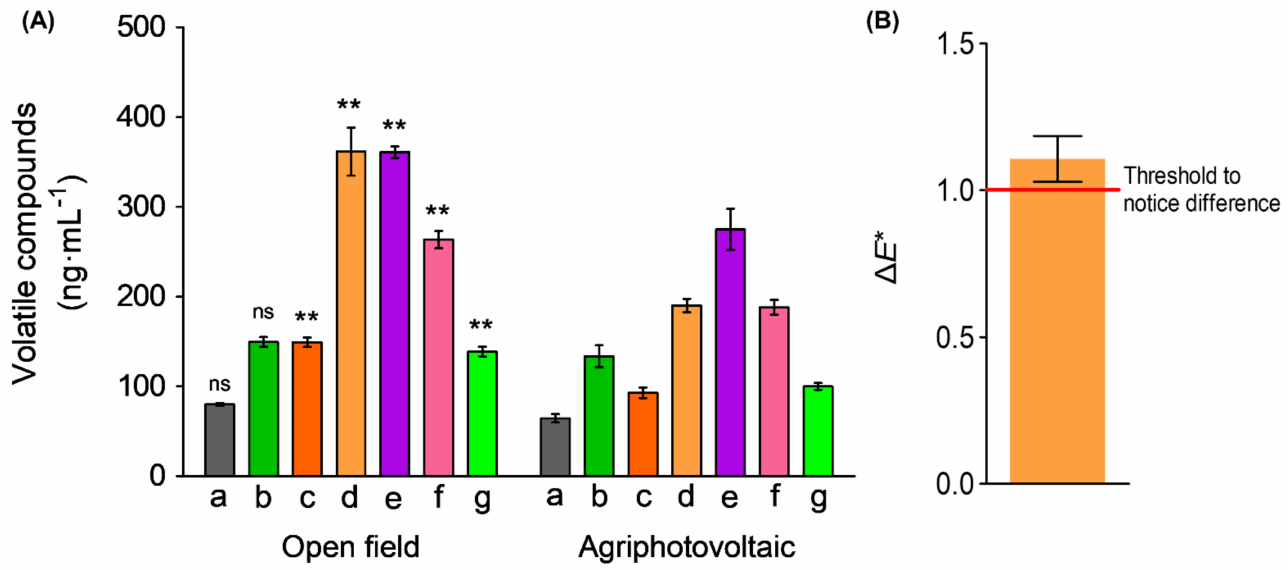
Figure 5. Volatile organic compounds ( A ) and color difference ( ∆ E *) of cabbage juice OF when compared with APV ( B ). Different letters indicate the following: a—furanone; b—furfural; c—2- methylpyrazine; d—2,5-dimethyl pyrazine; e—dimethyl trisulfide; f—1h-pyrrole-2-carboxaldehyde; g—s-methyl methanthiosulphonate. Asterisks (* and **) indicate significant differences in Student’s t-test ( p < 0.05 and 0.01, respectively, n = 3 technical replicates) between OF and APV. ns—non-